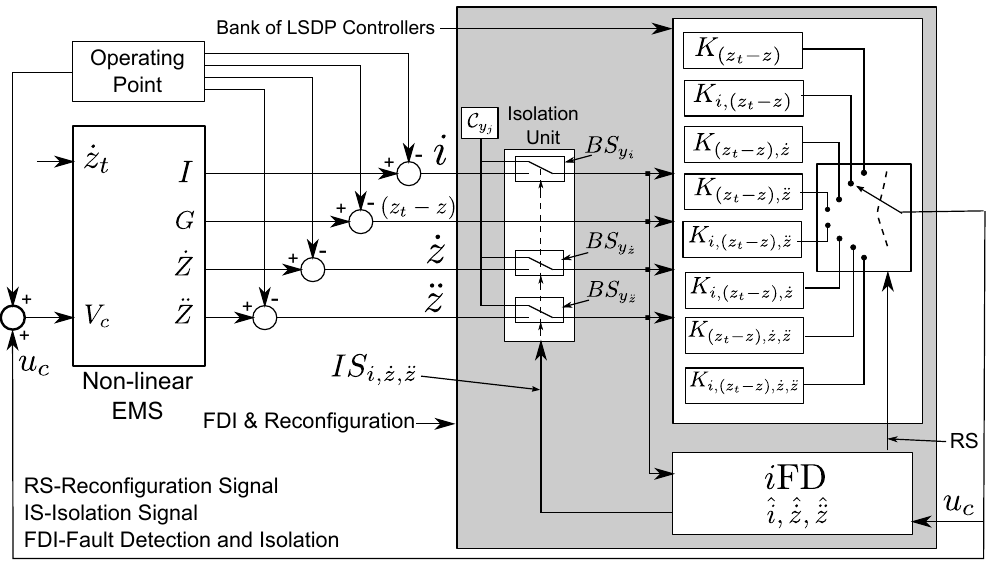
Figure 3. The proposed i FD solution using the EMS application example (basis from [19]).